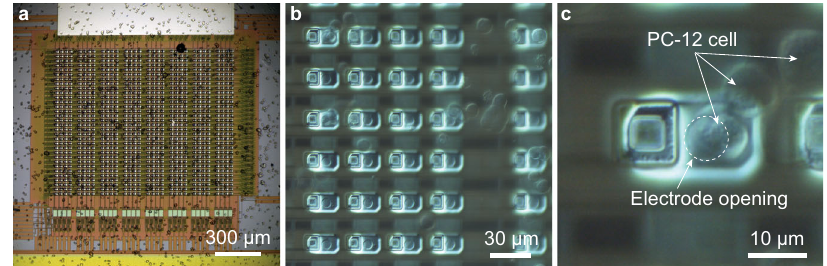
Fig. 2 On-chip recording of PC-12 cells. a The settled cells on the surface of the device. b Cells are seen in single-cell form, as well as clumps of cells, throughout the electrode array. c Cells have settled atop the electrode openings, permitting electrochemical monitoring of quantal